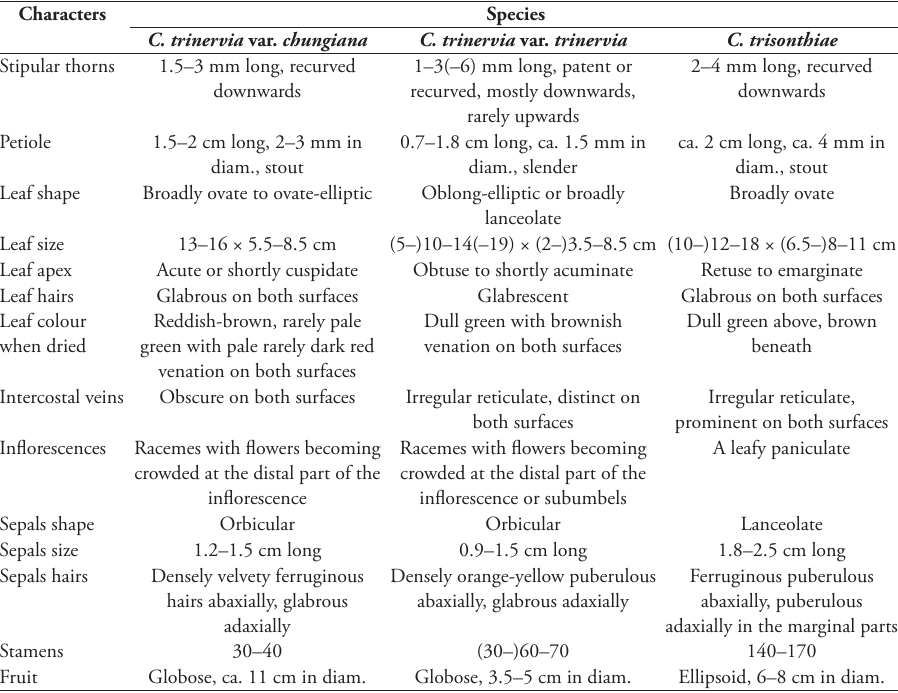
Table 2. Morphological comparison of Capparis trinervia var. chungiana , C . trinervia var. trinervia and C . trisonthiae